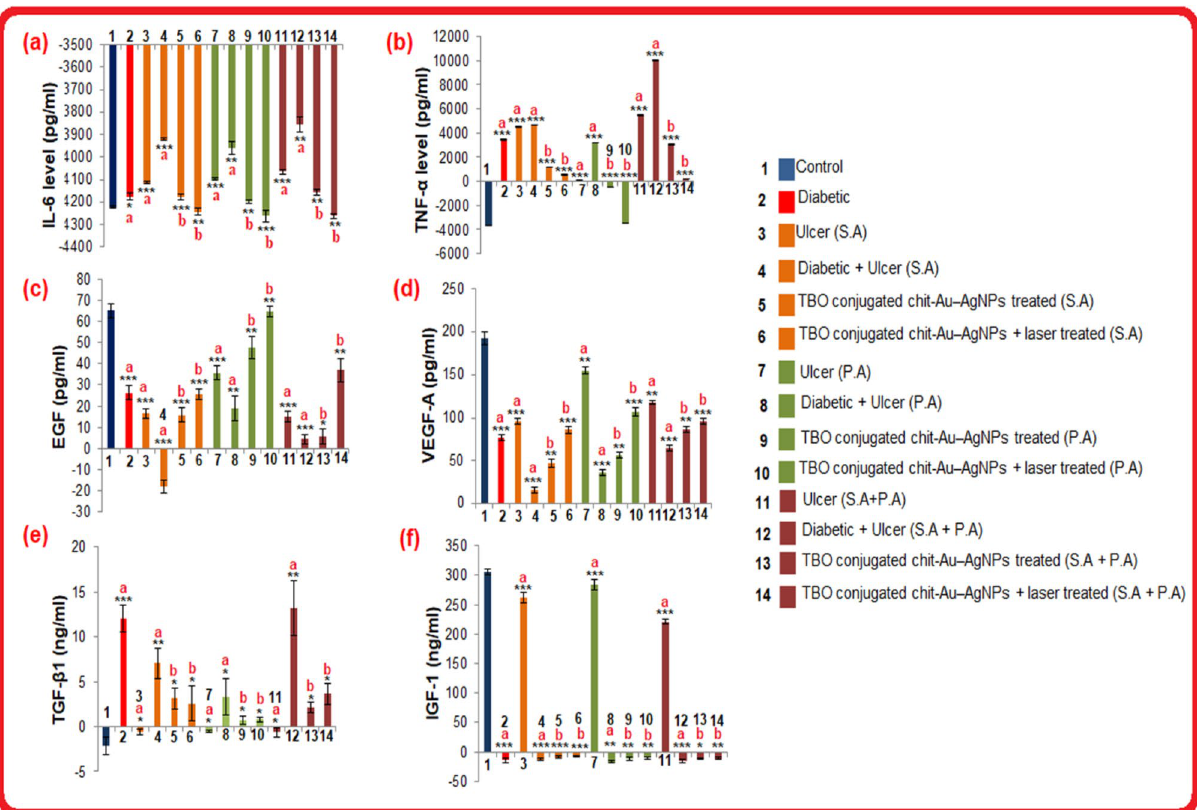
Figure 12. Effect of TBO–chit–Au–AgNPs mediated photodynamic therapy on pro-inflammatory cytokines and growth factors levels in Control rats, STZ induced diabetic rats (untreated), Ulcerated rats (untreated), DFU rats (untreated), DFU rats treated with TBO–chit–Au–AgNPs, DFU rats treated with TBO–chit–Au– AgNPs + laser: ( a ) IL-6 level, ( b ) TNF-α level, ( c ) EGF level, ( d ) VEGF-A level, ( e ) TGF-β1 level and ( f ) IGF-1 level. Each bar represents mean ± SD of 4 rats. Significance at: p-value *p < 0.01, **p < 0.001, ***p < 0.000, ns = not significant. a—compared with control or normal rats; b—compared with untreated diabetic foot ulcer